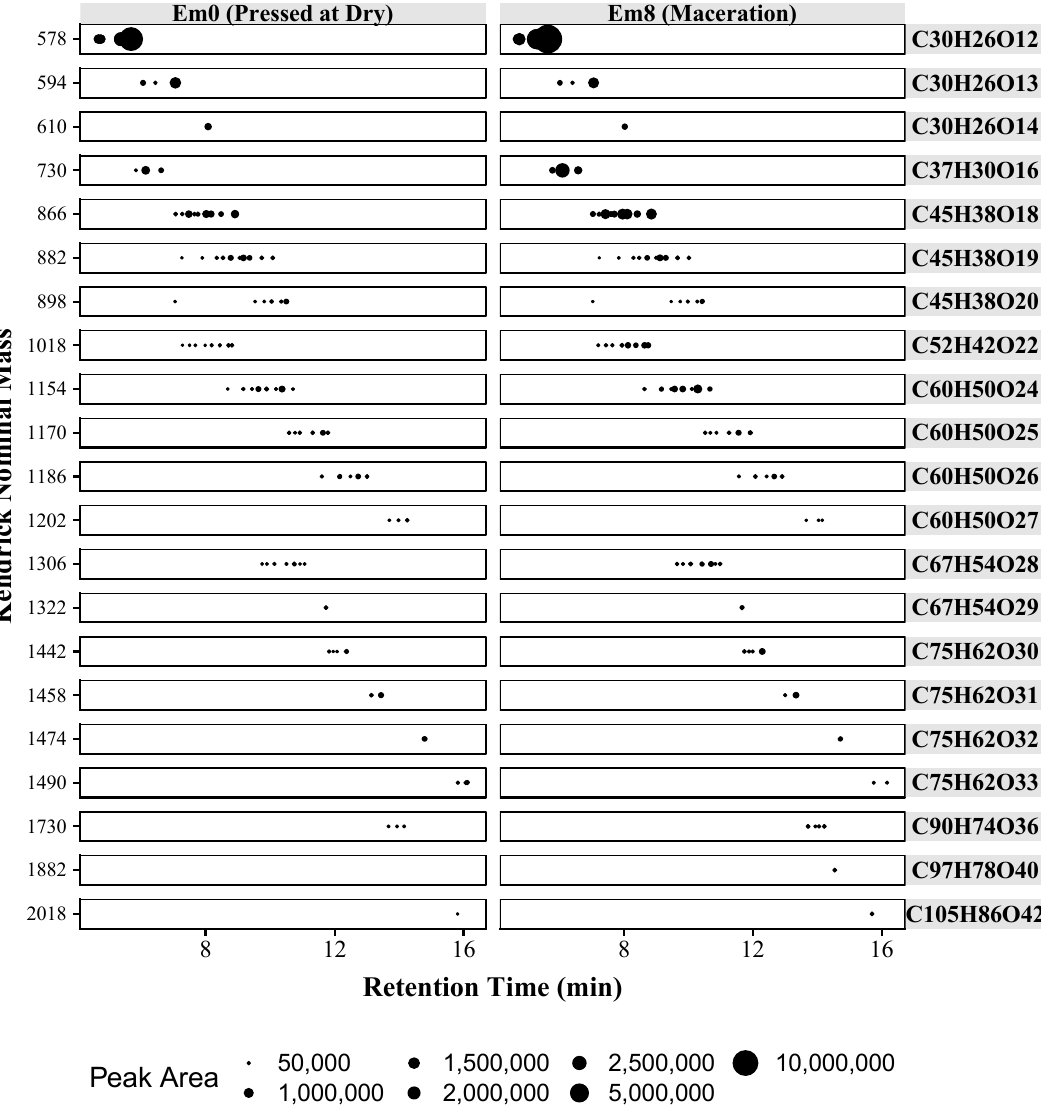
Figure 6. Proanthocyanidin polymers in Merlot wines produced with two different maceration techniques. Each dot represents a putative proanthocyanidin compound. Hydrophilic interaction liquid chromatography (HILIC) retention time is plotted vs. Kendrick nominal mass and absolute peak area is indicated by the dot size. Each horizontal lane indicates the nominal mass and the identified chemical formula. Extended maceration (Em).